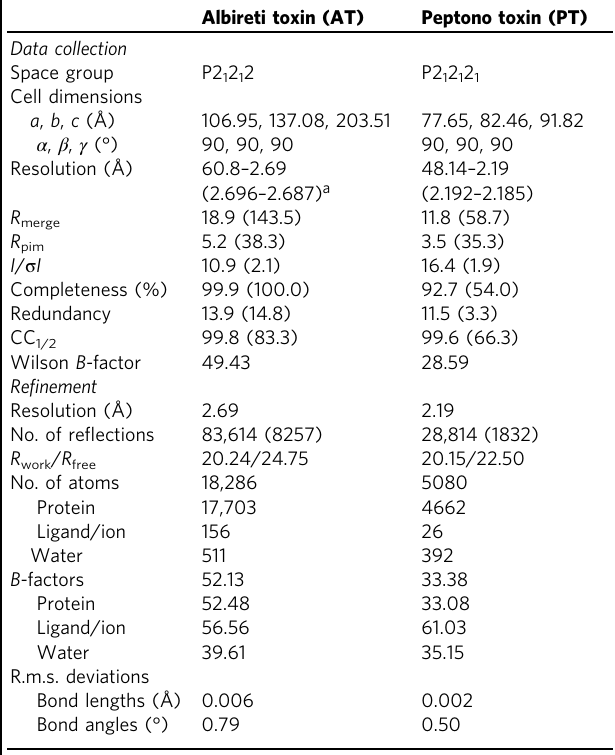
Table 1 Data collection, phasing, and re fi nement